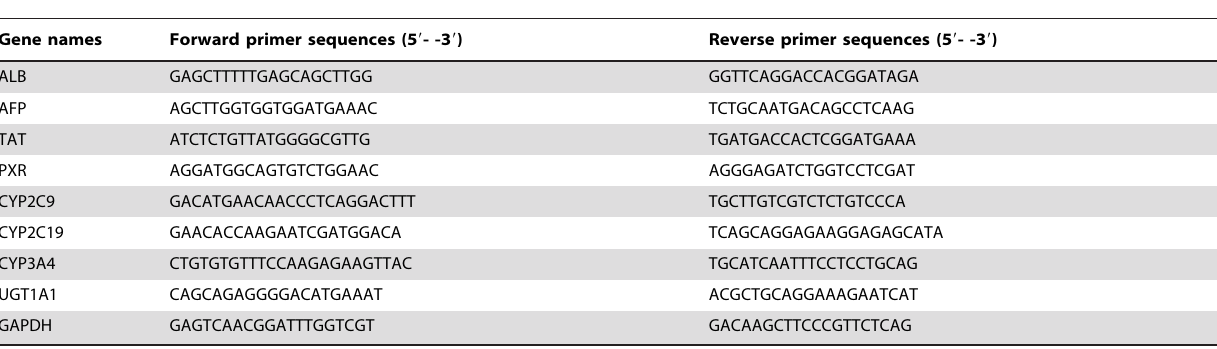
Table 1. Sequences of primers for real-time RT-PCR